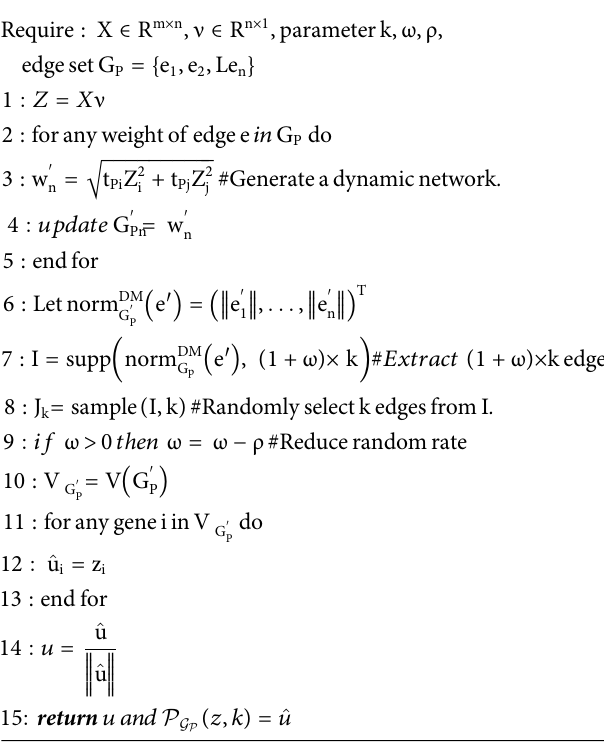
Algorithm 1. Random sampling algorithm based on the greedy principle sparse projection for the dynamic